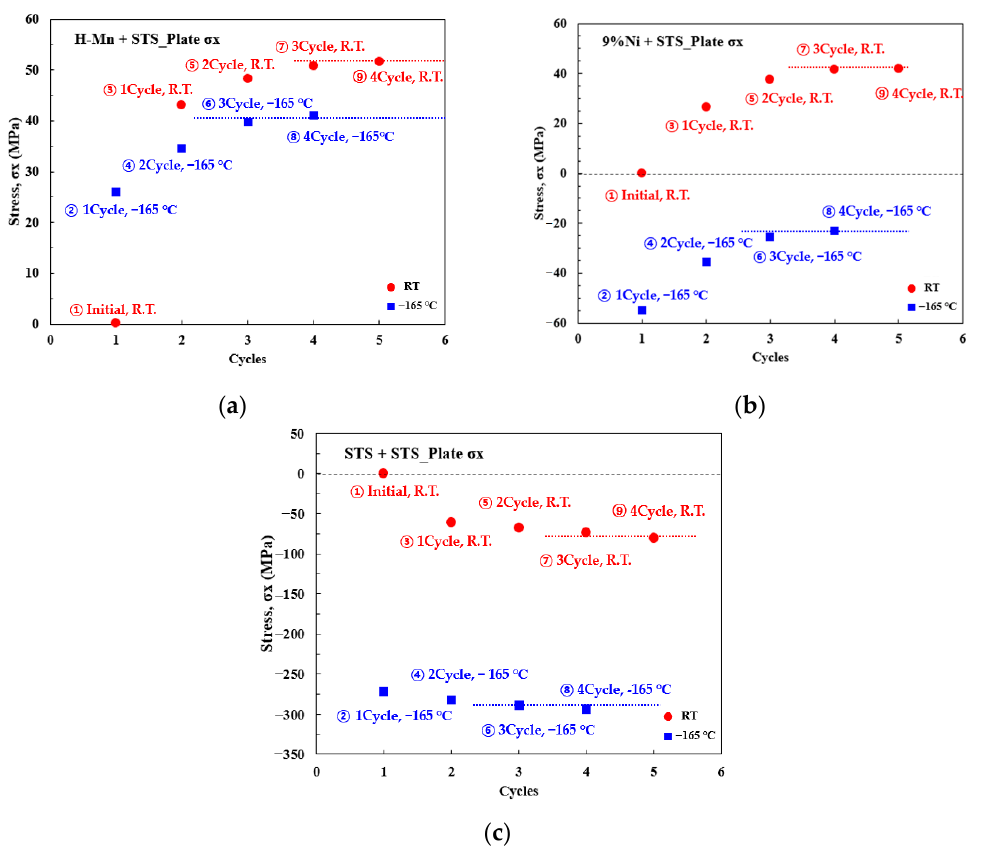
Figure 7. Stress values at each cycle for ( a ) high-manganese austenitic steel, ( b ) 9% Ni steel, and ( c )